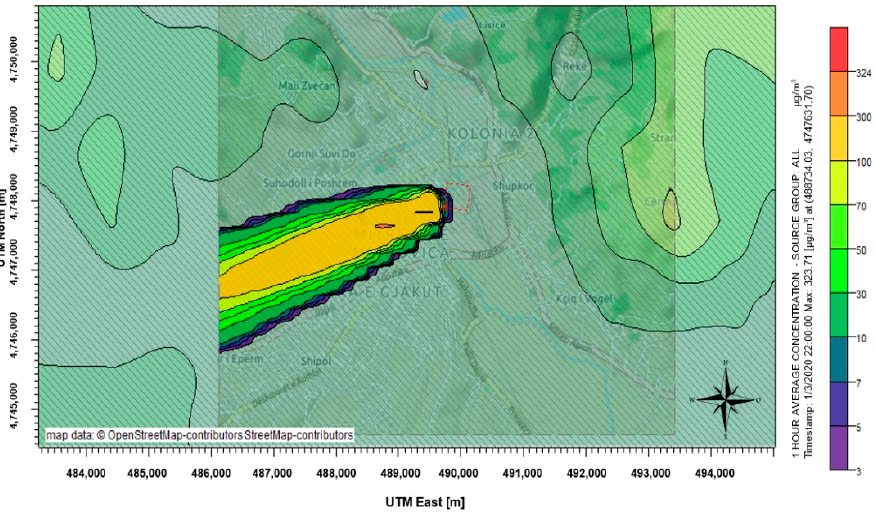
Figure 12. Plume animation cross-section of the pollution flow in the given weather conditions.